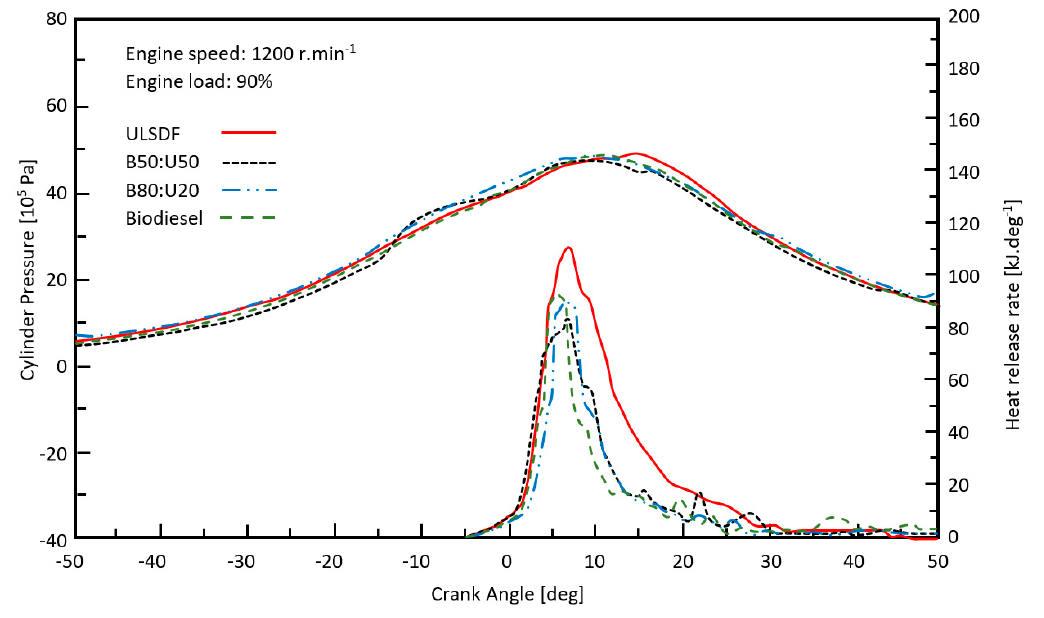
Figure 4. Tested fuels’ influence on the heat release rate and cylinder pressure at 1200 rpm and 90% load.